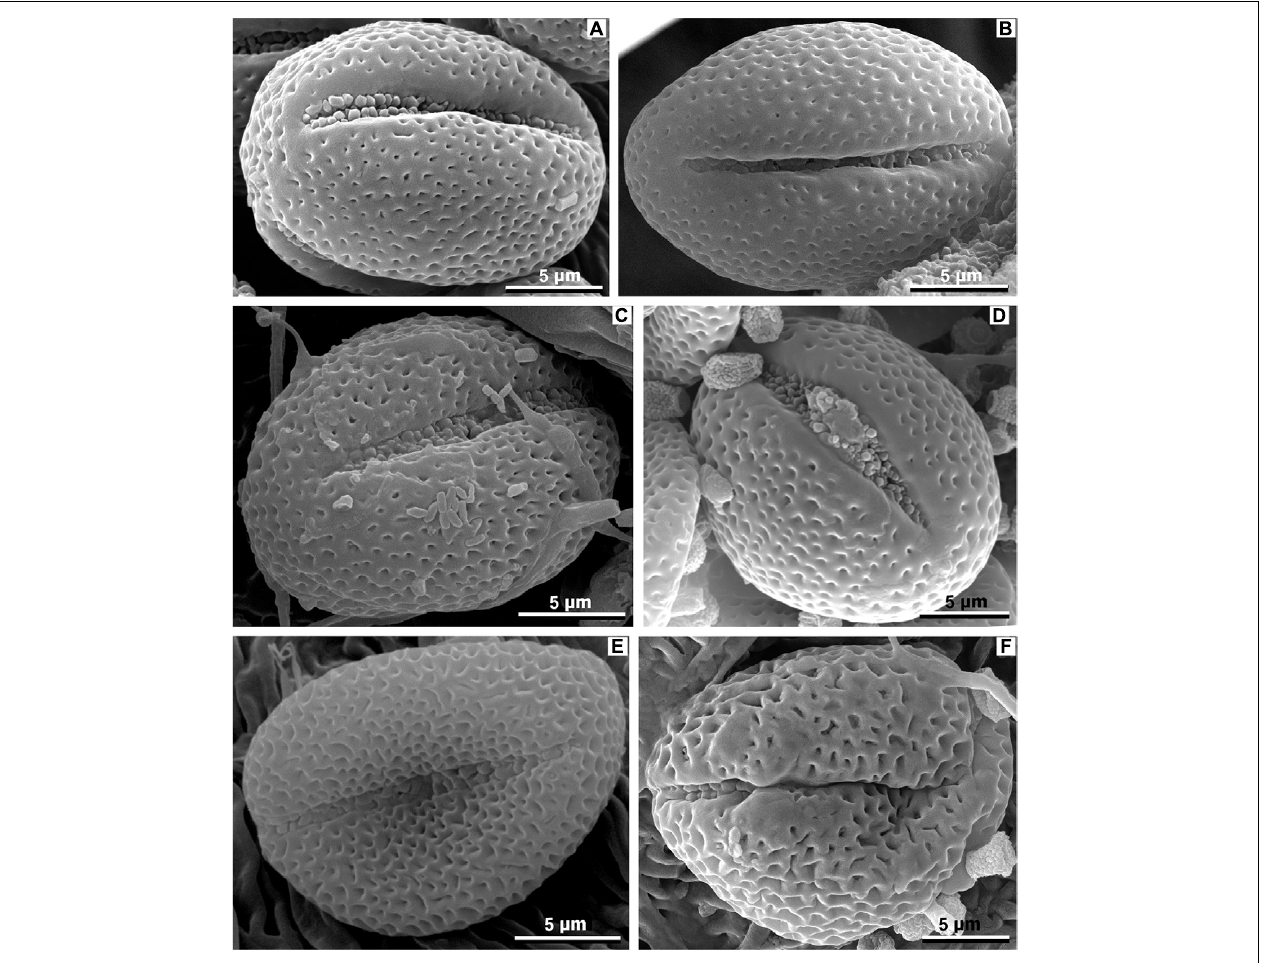
FIGURE 14 | Pollen of extant species of Meliosma , equatorial view, SEM. (A,B) M. rhoifolia Maxim., SYS00085206. (C) M. rigida Siebold et Zucc., SYS00085214. (D) M. angustifolia Merr., SYS00085105. (E) M. fruticosa Blume, SYS00085274. (F) M. simplicifolia (Roxb.) Walp., SYS00085273.